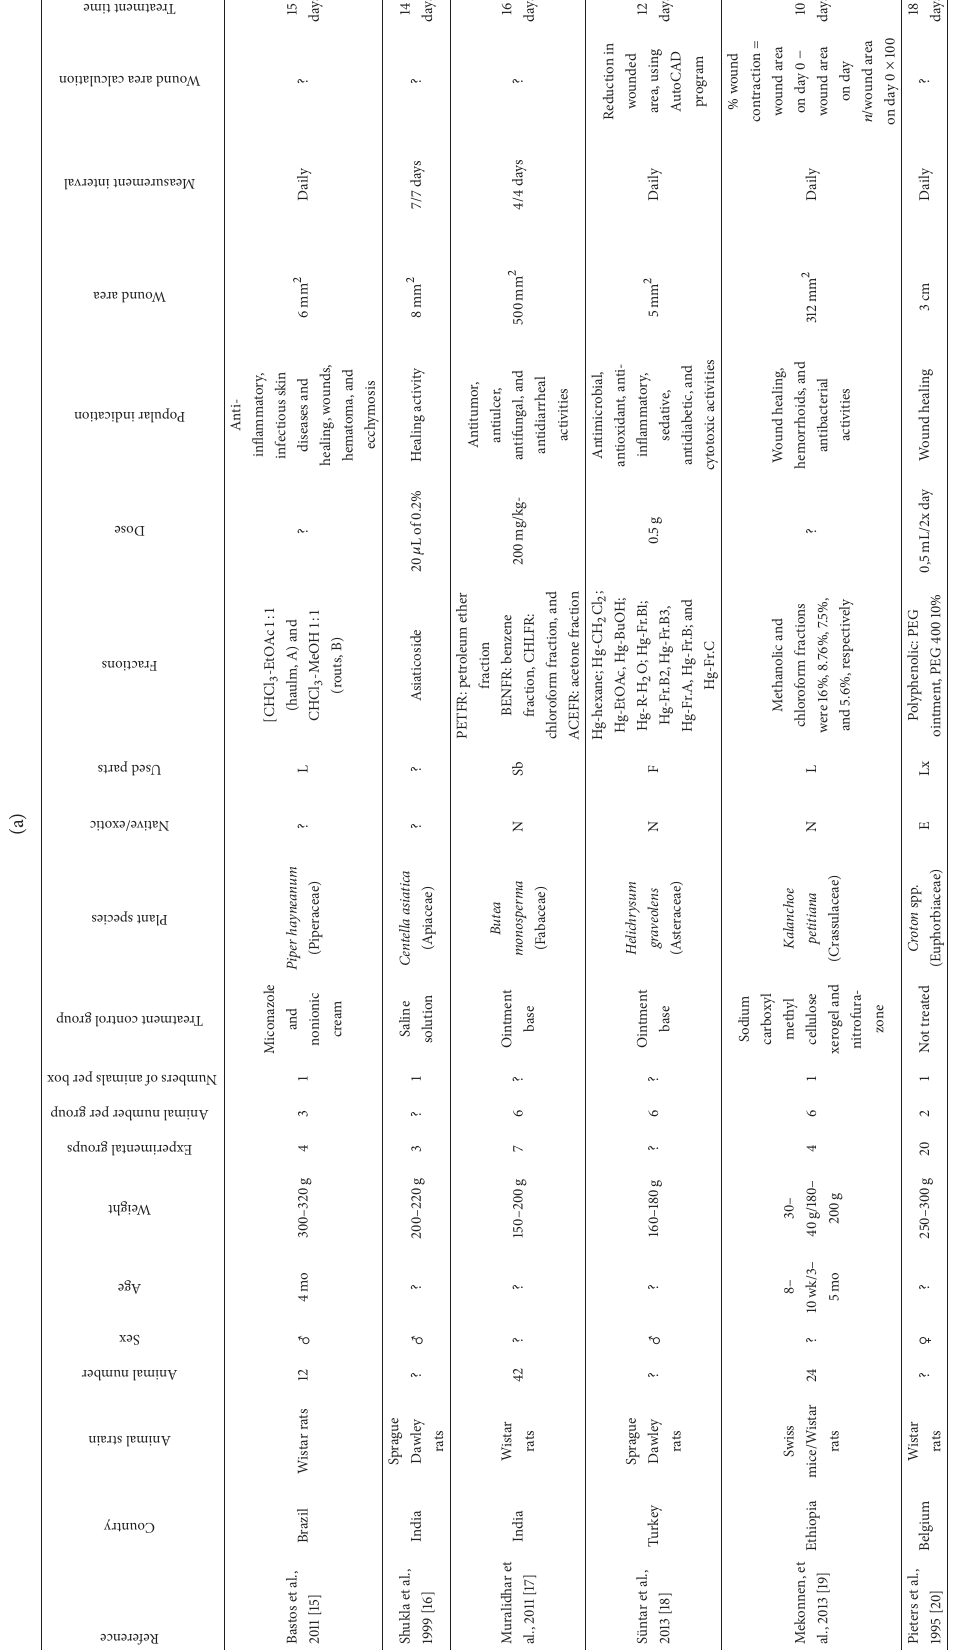
Woundareacalculation